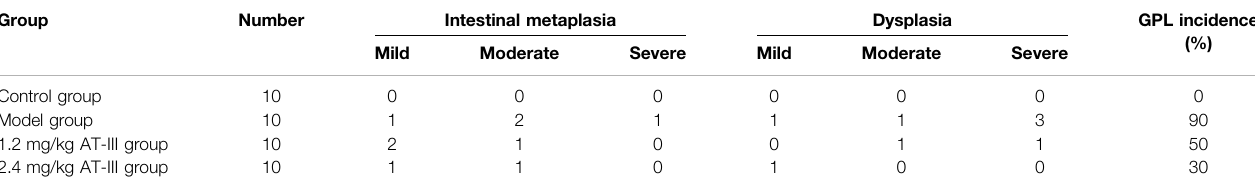
TABLE 1 | The incidence rate of GPL in each group. Group